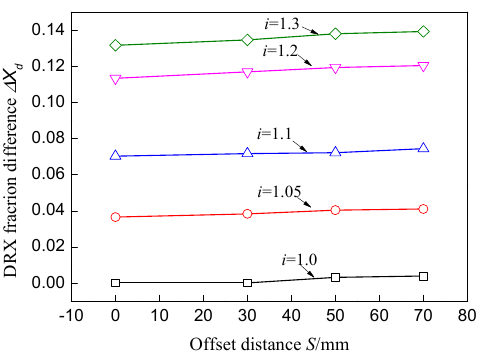
Figure 7. Effect of offset distance on DRX fraction difference between the upper and lower surfaces during asymmetrical shear rolling.